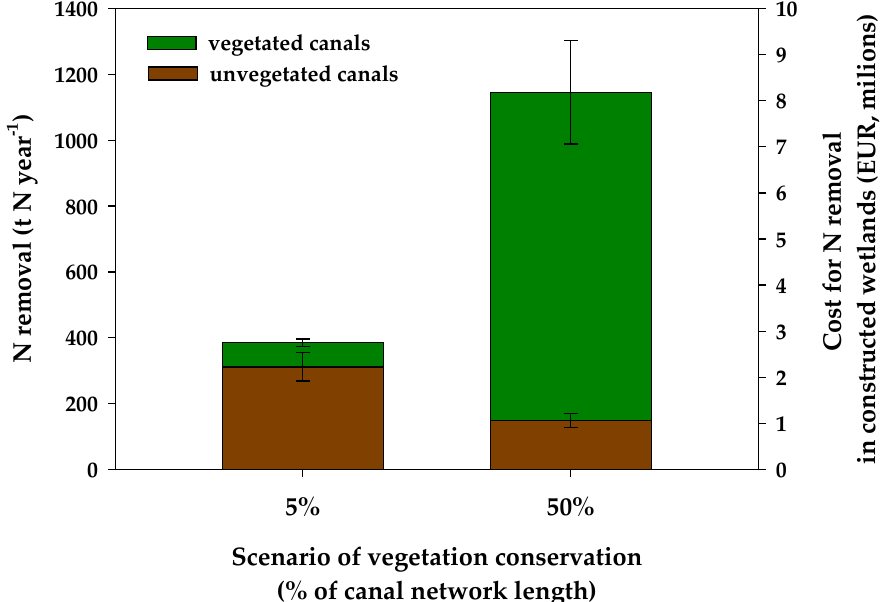
Figure 3. Predicted N removal with vegetation conservation on 5% (actual scenario) and 50% (new scenario) of the canal network length. The corresponding cost for N removal in constructed wetlands is also reported. Table 3. Impact categories results for current and conservative scenarios. All Impact categories are referred to 1 linear km of canal, during a whole vegetative season; CV% was calculated from Montecarlo simulation (1000 runs).